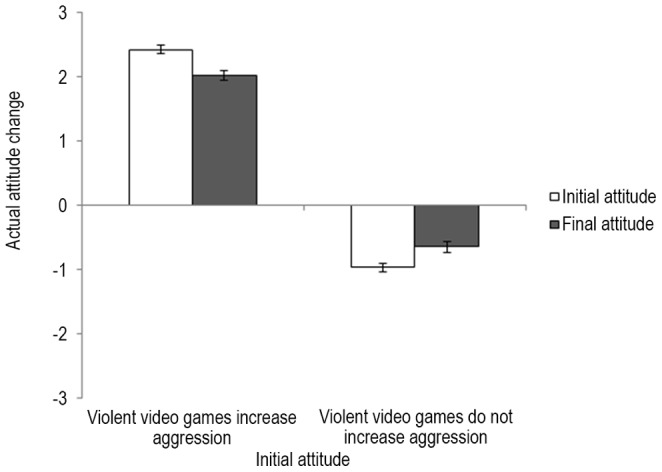
Mean actual attitude change as a function of initial attitude.Error bars depict two standard errors.